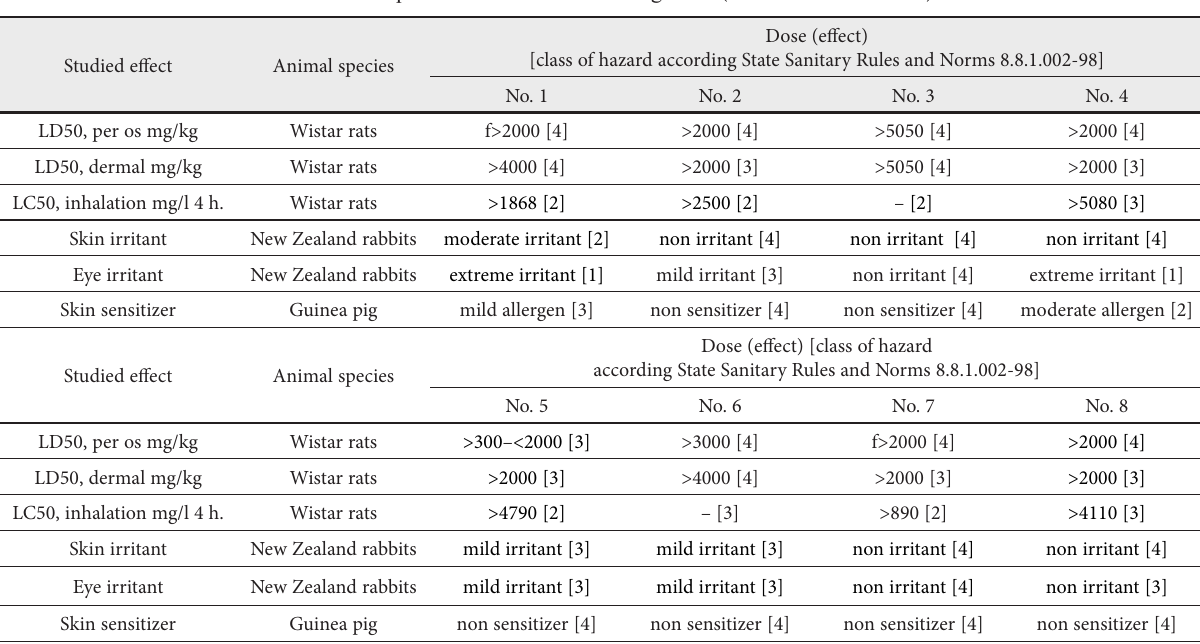
Toxicometric parameters of combined fungicides (Formulations No.